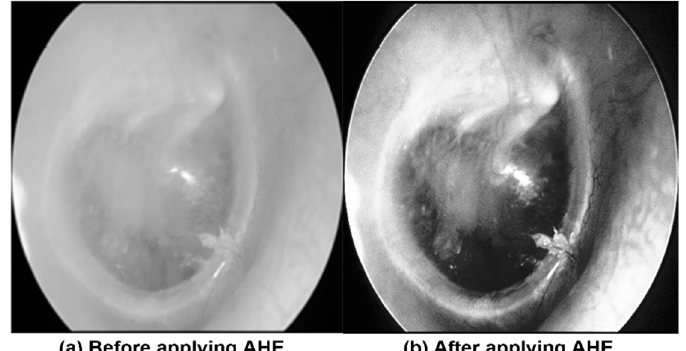
Figure 3. Before and after applying AHE.